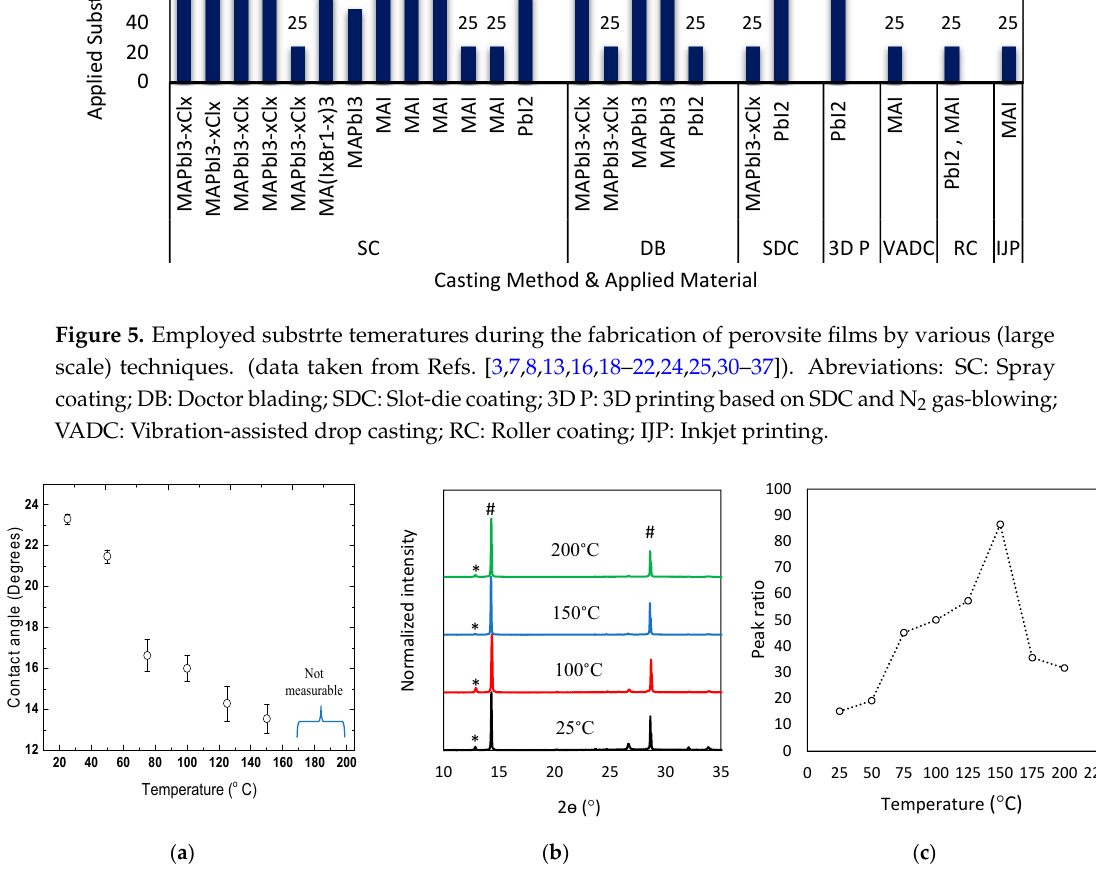
Figure 6. ( a ) contact angle of the perovskite solution droplets (MAPbI 3 − x Cl x in DMF) versus substrate temperature; ( b ) XRD patterns of MAPbI 3 − x Cl x perovskite films, spray deposited on FTO-coated glass substrates at various substrate temperatures (# and * represent the perovskite and PbI 2 peaks, respectively); ( c ) the quantified conversion ratios at various substrate temperatures. At temperatures higher than the boiling point of DMF (>153 ◦ C), measurement of the contact angle was found to be not accurate, due to rapid solvent evaporation. It is noted that, after deposition, all perovskite films were annealed at 100 ◦ C for 2